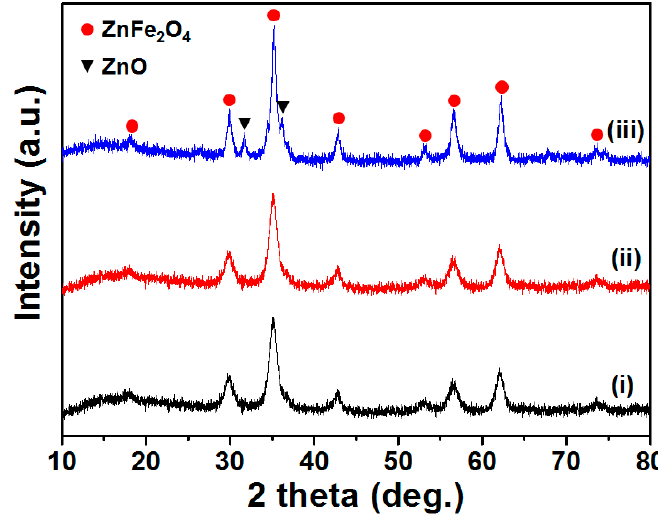
Figure 2. X-ray diffraction patterns of (i) ZFO, (ii) ZFO–G, (iii) ZFO–G–GL. The peaks corresponding to ZnFe 2 O 4 and ZnO are labeled with circles and triangles, respectively.